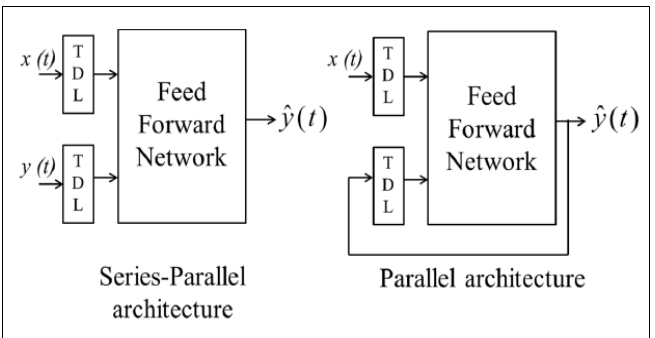
Figure 5: NARX neural network